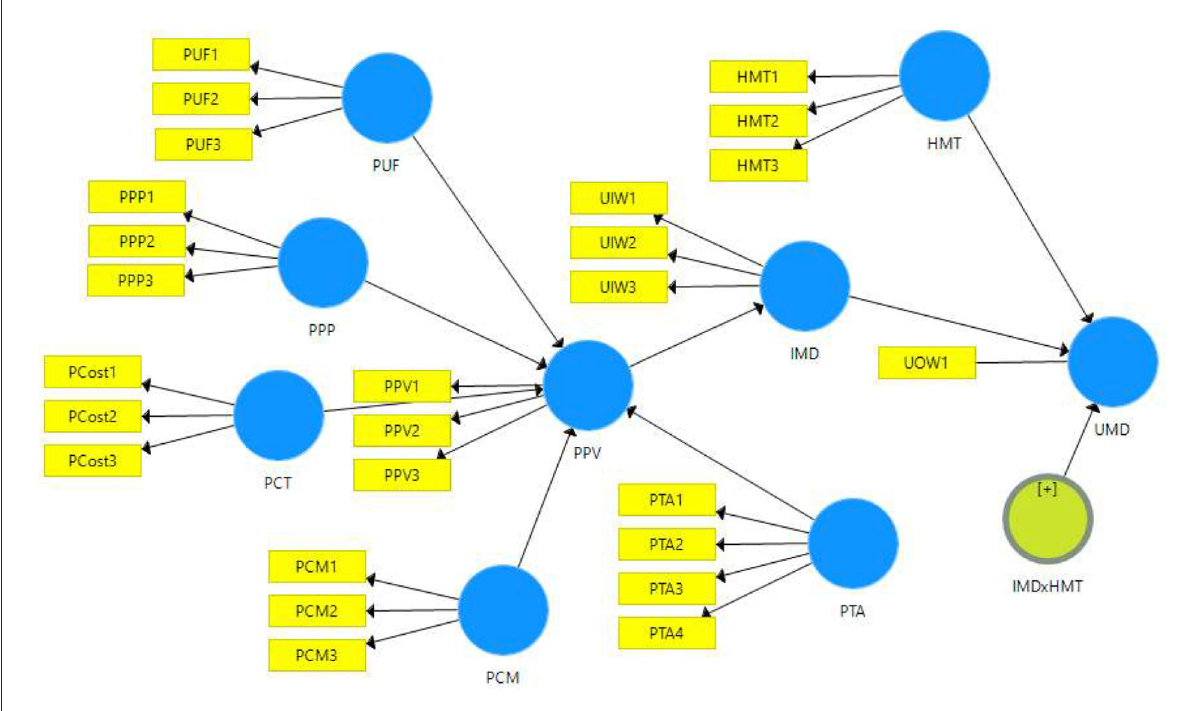
FIGURE1 Study model.